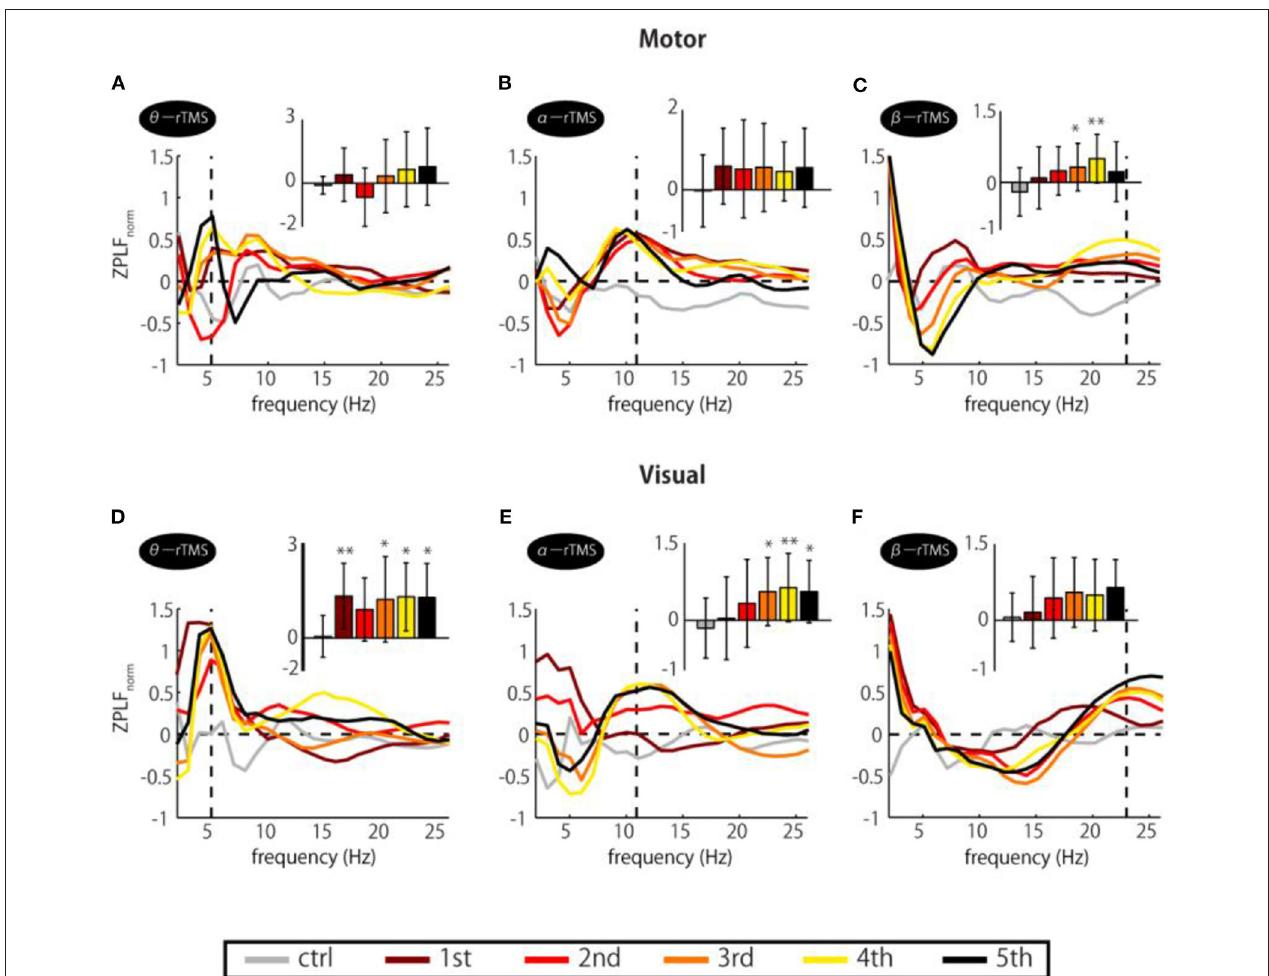
FIGURE 3 | Changes in ZPLF norm over TMS train. Each colored line corresponds to ZPLF norm for each TMS pulse to the motor (A–C) and the visual cortex (D–F) . Together, they indicate which frequency was the most prominent during the train and how it varied with pulse repetition. The charts inset in each panel indicate the ZPLF norm at the frequency corresponding to the rTMS stimulation frequency, i.e., the values of ZPLF norm at the vertical dashed line. Significant changes from the baseline control period (ctrl) were assessed by Dunnett’s test (* p < 0.05, ** p < 0.01). The baseline was the mean value during the period from − 5 to − 2 stimulation-frequency cycles. Error bars: